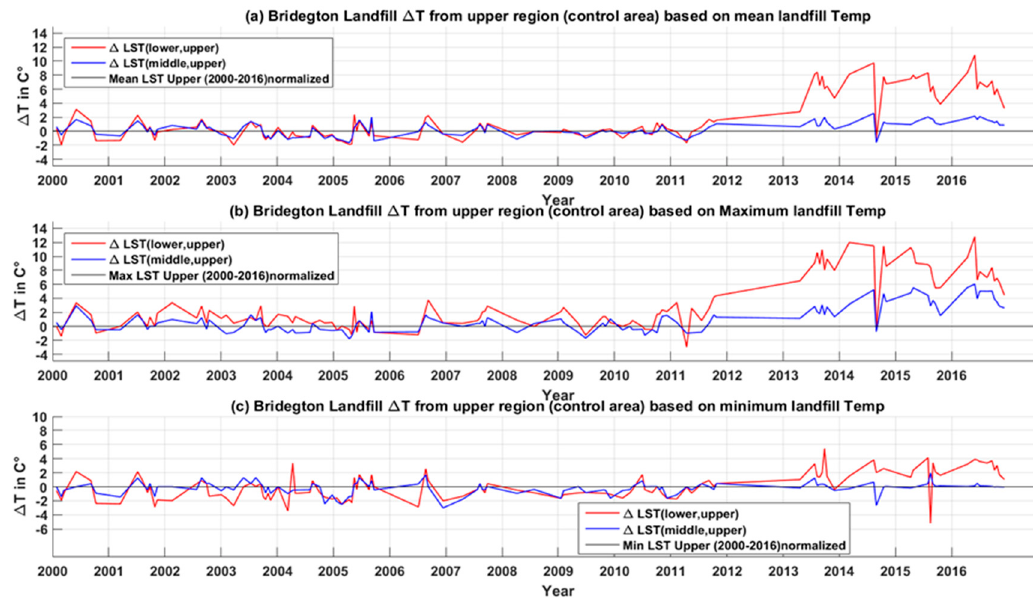
Figure 5. Taking the upper region as a ”control” and comparing it with the lower/middle regions.